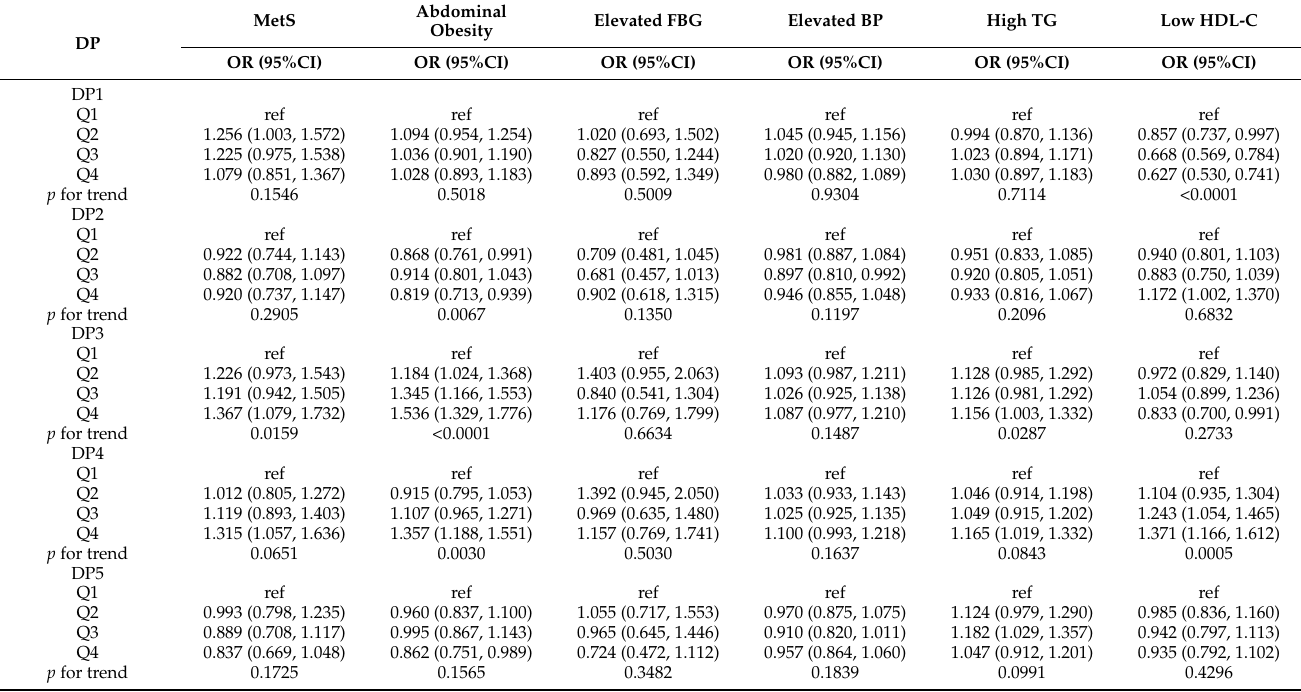
Table 3. The associations between dietary patterns with MetS and its components by logistic